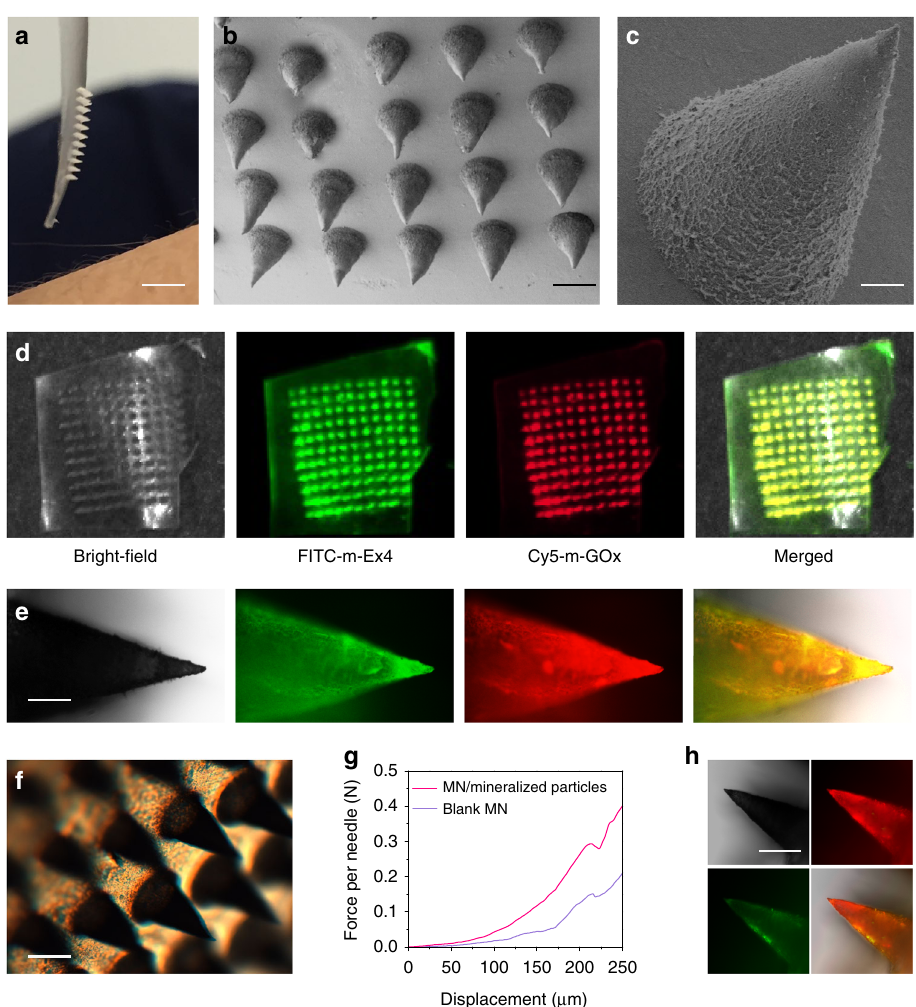
Fig. 5 Characterization of dual mineralized particle-loaded MN-array patches. a Photograph of the smart Ex4 patch with an MN array. Scale bar, 0.5 cm. b SEM image of the MN array. Scale bar, 500 µ m. c Magni fi cation of a single microneedle. Scale bar, 100 µ m. d , e Fluorescence microscopy images of the MN arrays and a single needle containing FITC-m-Ex4 and Cy5-m-GOx. Scale bar, 150 µ m. f Bright- fi eld image of the MN array after 30 days storage. Scale bar, 400 µ m. g Mechanical behaviors of MNs with or without mineralized particles. h Fluorescence images of a single microneedle containing FITC-m-Ex4 and Cy5-m-GOx after exposure to 400 mg dl − 1 glucose for 24 h. Scale bar, 300 µ